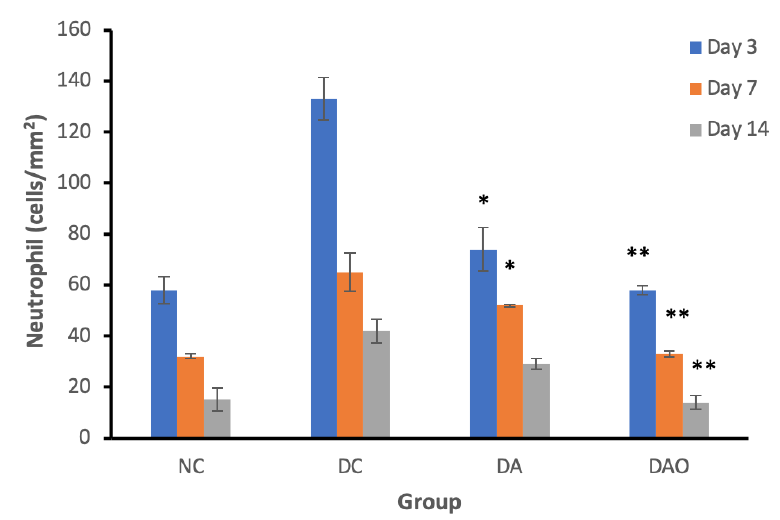
Figure 6. Graph of the number of neutrophils. Notation on the graph shows the result of the statistical test (α < 0.05). (*) and (**) notation shows insignificant differences with NC, but significant differences with DC. * = 0.01 ≤ α < 0.05; ** = α ≤ 0.01. NC—normal control group; DC—diabetic control group;